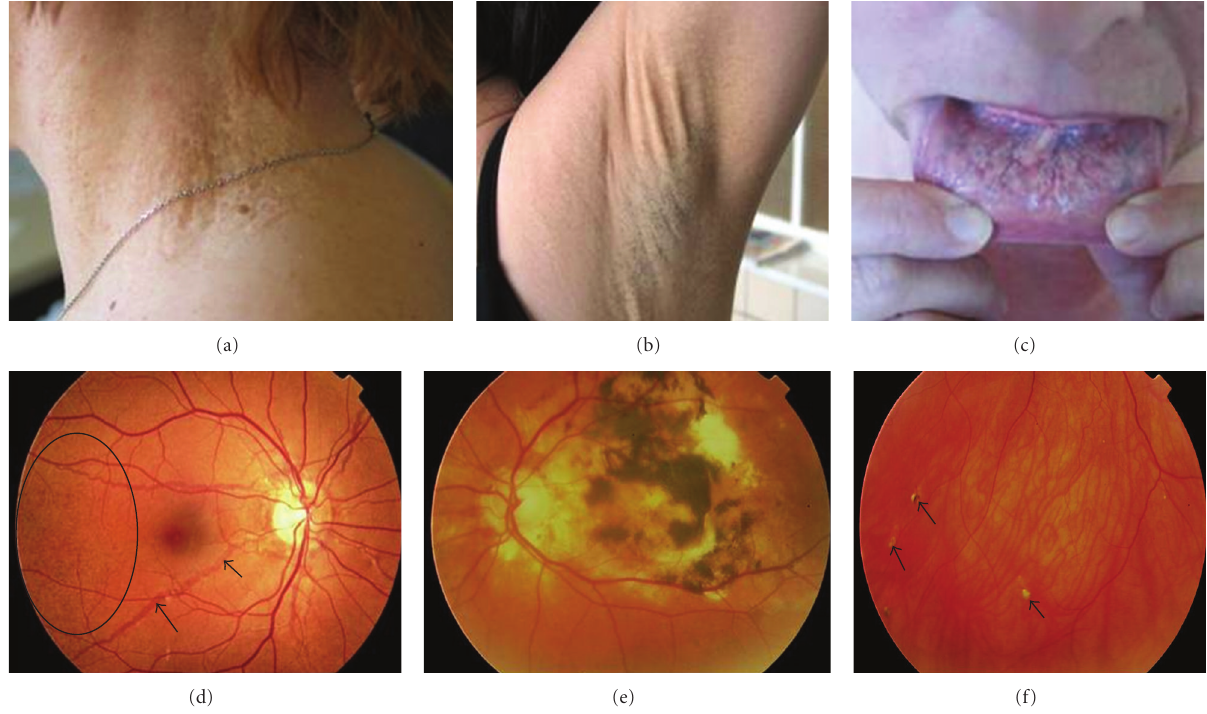
Figure 3: Cutaneous and ophthalmological symptoms of PXE. Plaques of papules in the neck region (a), increased skin laxity (b) and mucosal involvement with yeloowish pattern on the inner lip (c). The retinopathy consists of peau d’orange (d, oval), angioid streaks (d, arrowed), retinal hemorrhaging (e). In some cases calcifications of Bruch’s membrane can be seen as comets or comet tails (f,